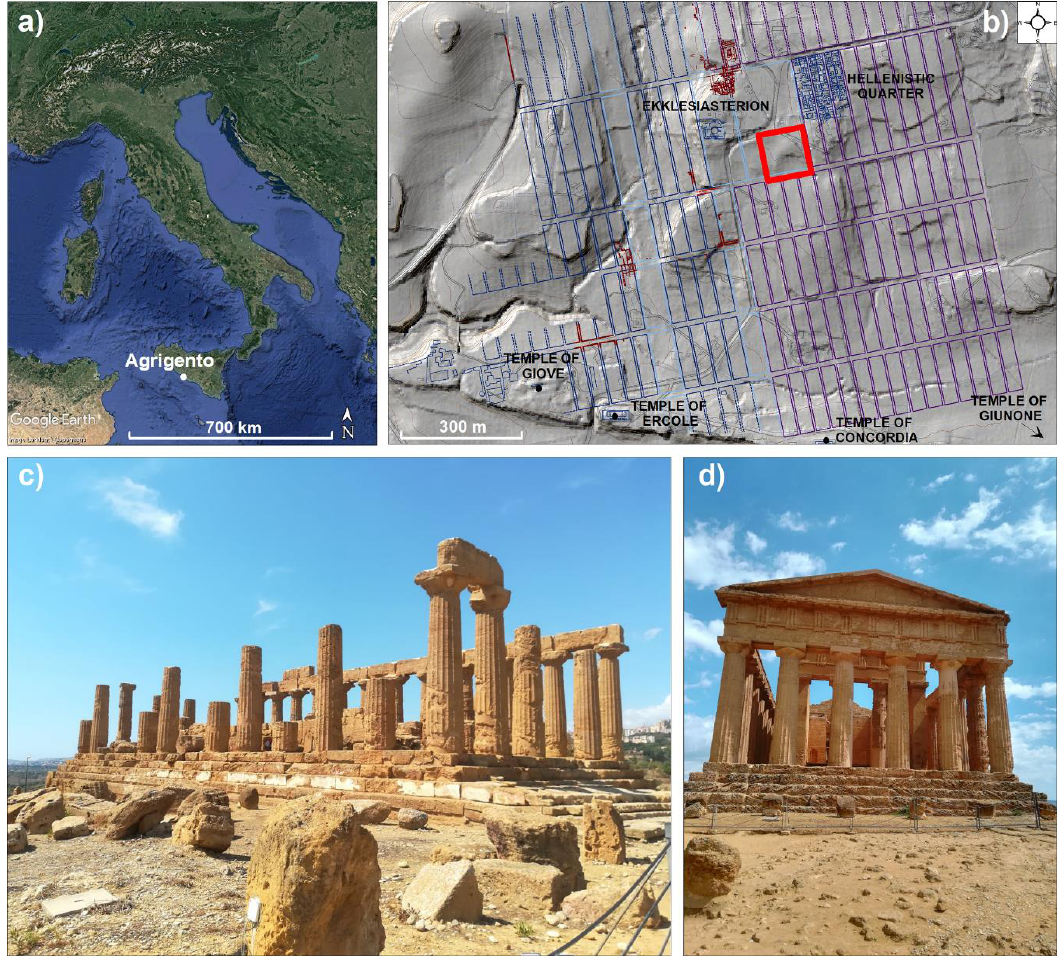
Figure 1. Location of Agrigento on a Google Earth TM satellite image ( a ), reconstructive map of ancient Agrigento on Laser Imaging Detection and Ranging (LIDAR) analysis (made by G. Pambianchi and F. Pallotta, Camerino University) with indication of the surveyed area in red (modified by Brienza [2]) ( b ), the Temple of Giunone ( c ), and Temple of Concordia ( d ).